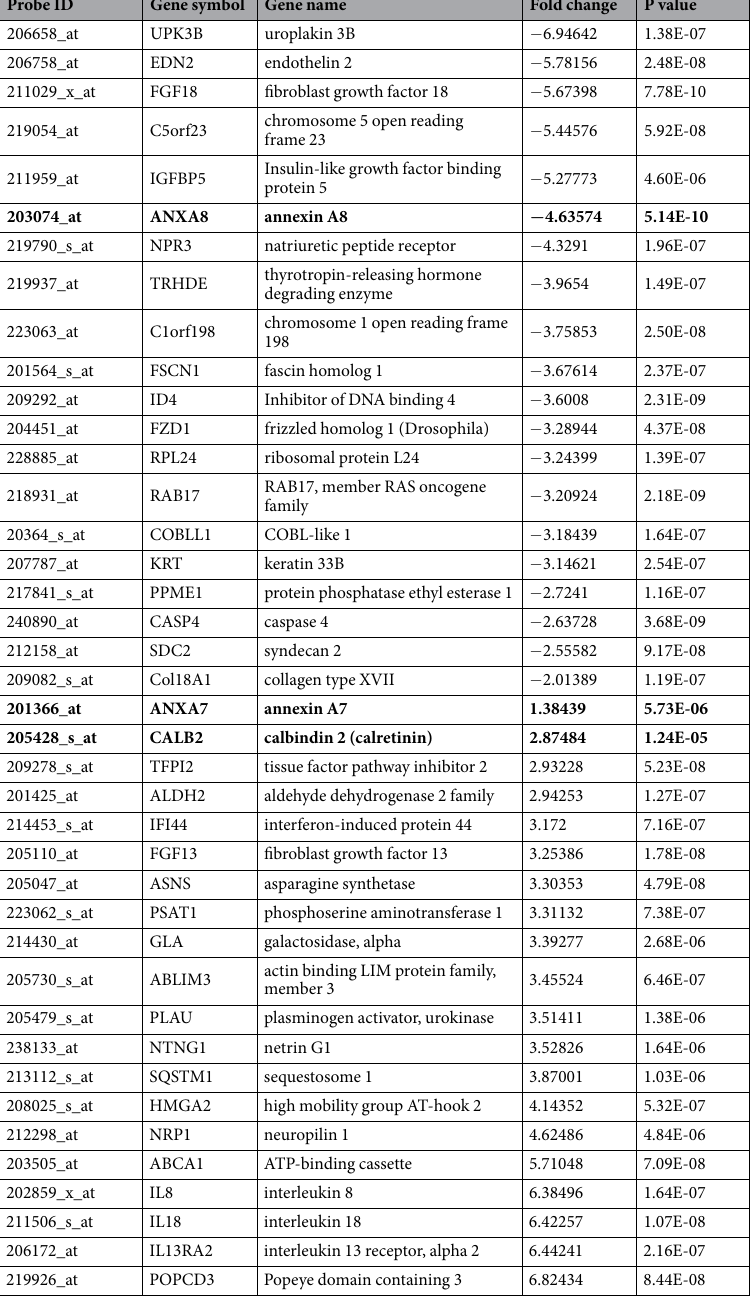
Table 1. Microarray data pre- and post-FR treatment showing 40 of the most up- and down-regulated genes and their fold change in response to FR versus control treatment. AnxA8 was one of the most down-regulated genes, while AnxA7 was almost unchanged. The neuronal marker calretinin was up-regulated in FR-treated ARPE-19